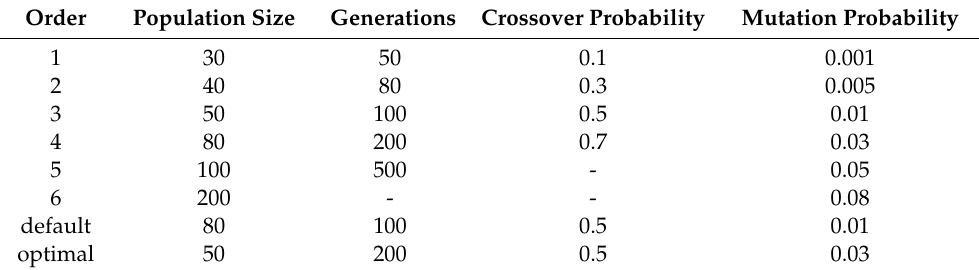
Table 4. Parameters selected for sensitivity analysis of non-dominated sorting genetic algorithms II (NSGAII).